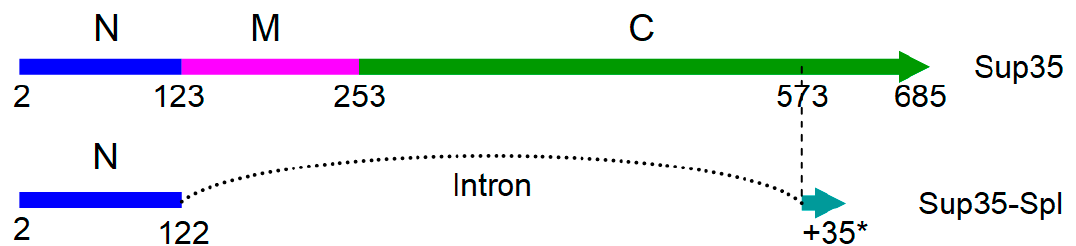
Figure 5. Comparison of the complete Sup35 protein and the one resulting from splicing. N , M and C domains of Sup35 and location of the intron are shown, along with amino acid numbering. The proteins start from residue 2, since first methionine is removed. Second exon includes 35 residues translated out of frame (*).